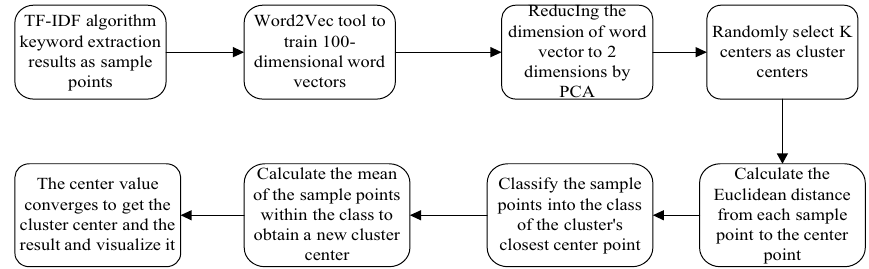
Fig. 1 Flowchart of Kmeans clustering